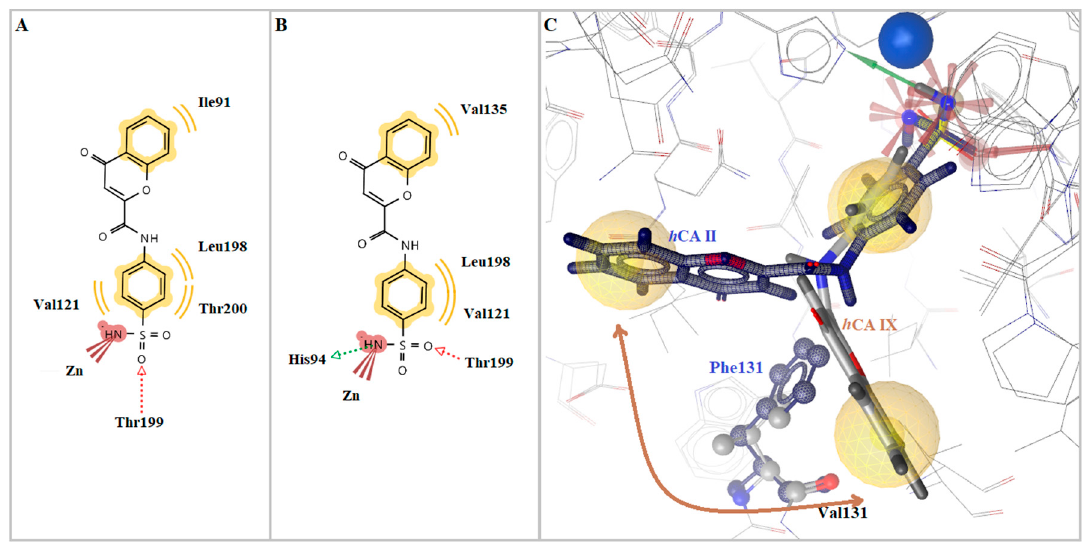
Figure 1. ( A ) 2D interaction diagram of compound 7 docking pose interactions with the key amino acids in hCA II, ( B ) in hCA IX, and ( C ) Superposition of compound 7 bound to hCA IX (grey) in comparison to hCA II (blue), with specific residues labeled. Active site zinc is shown as a blue sphere, red dotted and green arrows indicate H-bond, and yellow spheres indicate hydrophobic interactions. Brown double-headed arrow indicates the direction of conformational change of the compound bound to hCA IX- in comparison to hCA II. Table 2. Molecular docking free binding energies (kcal/mol) and interactions of tested compounds on hCA I, II, IX, and XII isoforms.